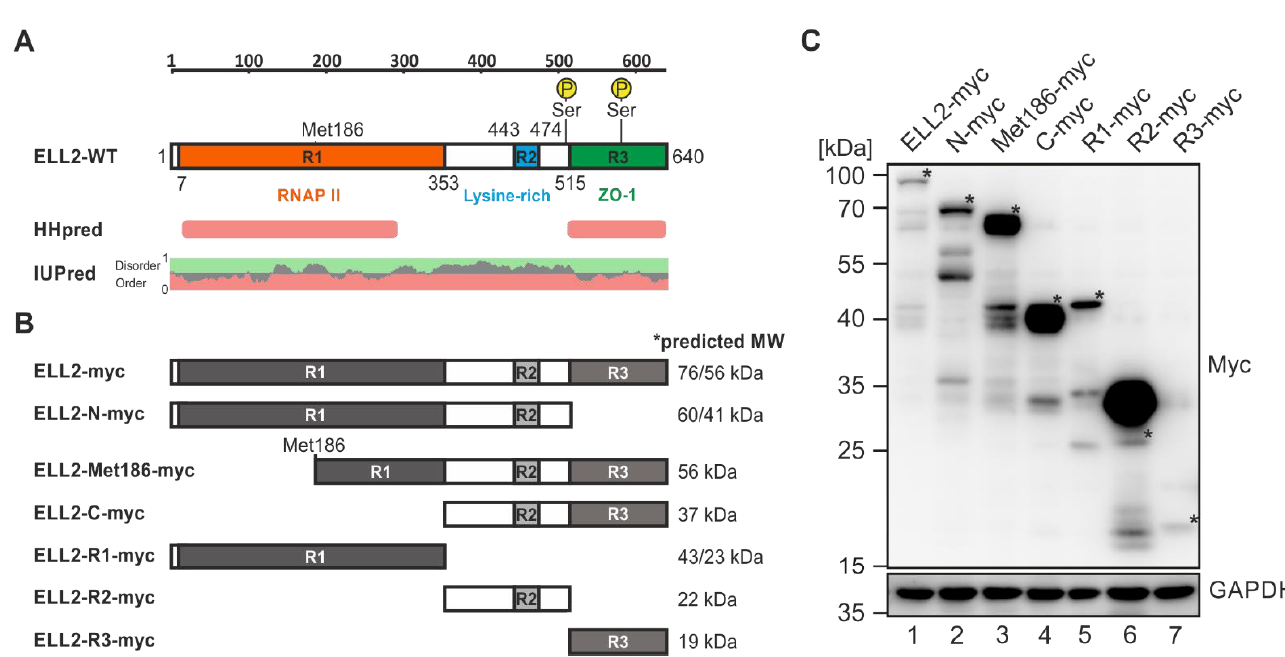
Figure 5. Characterization of ELL2 truncations and bioinformatic predictions of post translational modifications. ( A ) Schematic representation of ELL2 wildtype (ELL2-WT) and prediction of globular domains based on bioinformatic predictions using HHpred and IUPred. R1, R2, R3, conserved regions R1, R2, and R3; RNAPII, RNA polymerase II binding; ZO-1, homology to zonula occludens-1; Met186, alternative start codon. P Ser, phosphorylated serine residues. HHpred: Red bars indicate functionally related globular regions predicted through sequence comparisons of homologous, evolutionary related proteins of known 3D structure. IUPred: the prediction profile of protein disorder (green) tendency over the residue position. ( B ) Schematic representation of myc-his-tagged ELL2 truncations together with the respective predicted molecular weight (MW) values for proteins translated from the standard start codon (Met1, first value) and the alternative start codon at Met186 (second value), if applicable. ( C ) Expression analysis of ELL2 truncations. 293T cells were transfected with 1 µg of pEF-1α-driven expression plasmids ELL2-myc, N-myc, Met186-myc, C-myc, R1-myc, R2-myc, and R3-myc. After 48 h, cells were analyzed by Western blot using antibodies specific for Myc and the housekeeping gene GAPDH. * indicates bands corresponding to the predicted sizes (plus post translational modifications) of proteins translated from the first start codon being present.